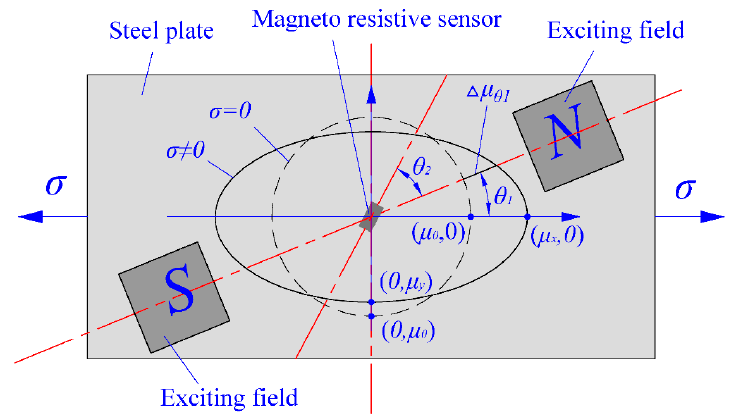
Figure 4. Influences of the relative orientation relationship of stress direction, main flux direction, and detection direction of a sensor on sensitivity.